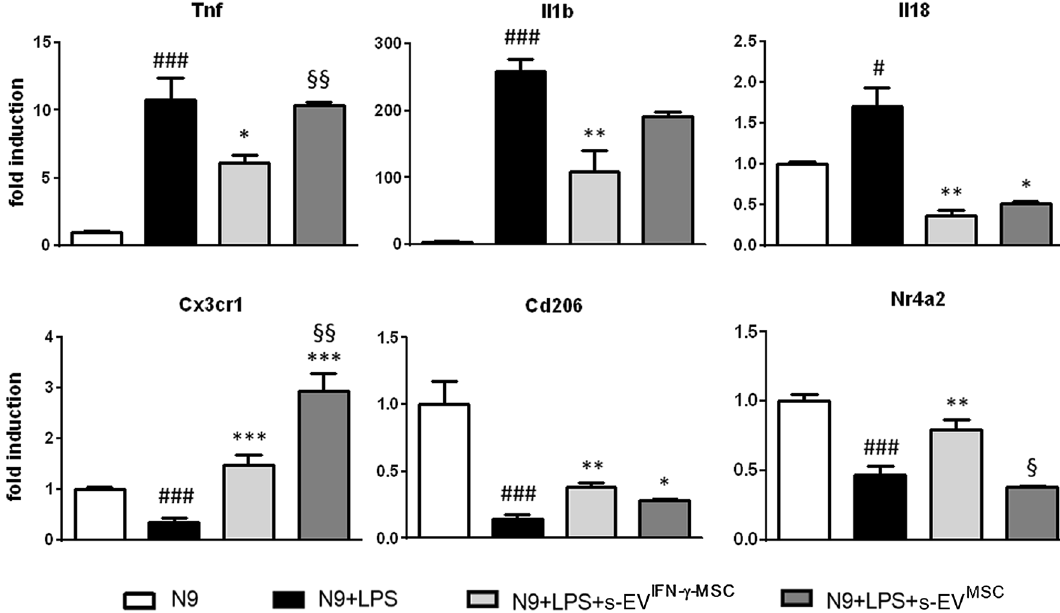
Figure 1. Exposure to MSC-derived s-EV affects the molecular phenotype of activated microglia. Enhanced anti-inflammatory effect of s-EV IFN-γ-MSC . RT-PCR quantification of genes associated with a pro- (Tnf, Il1b and Il18) and anti-inflammatory/neuroprotective (Cx3cr1, Cd206 and Nr4a2) phenotype in LPS-activated N9 cells. # P < 0.05 (Il18), ### P < 0.001 (Tnf; Il1b; Cx3cr1; Cd206; Nr4a2): untreated (N9) vs LPS-activated N9 cells (N9 + LPS); * P < 0.05 (Tnf; Il18; Cd206), ** P < 0.01 (Il1b; Il18; Cd206), *** P < 0.001 (Cxcr3): N9 + LPS vs N9 + LPS exposed for 24 h to s-EV IFN-γ-MSC (N9 + LPS + s-EV IFN-γ-MSC ) or s-EV MSC (N9 + LPS + s-EV MSC ); § P < 0.05 (Nr4a2), §§ P < 0.05 (Cx3cr1): N9 + LPS + s-EV IFN-γ-MSC vs N9 + LPS + s-EV MSC . Data are presented as mean ± SEM of 3 independent experiments conducted in